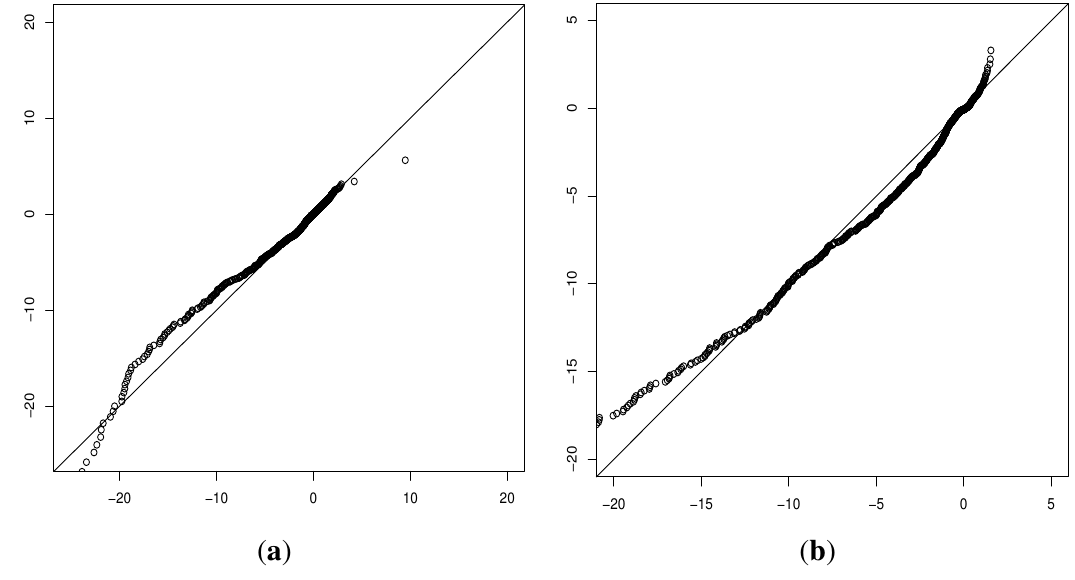
Figure S1. QQ plots of known variant data ( x -axis) against samples ( n = 1,000,000) from lowest-AIC distribution for set as detailed in Table S1. ( a ) Deleterious; ( b )